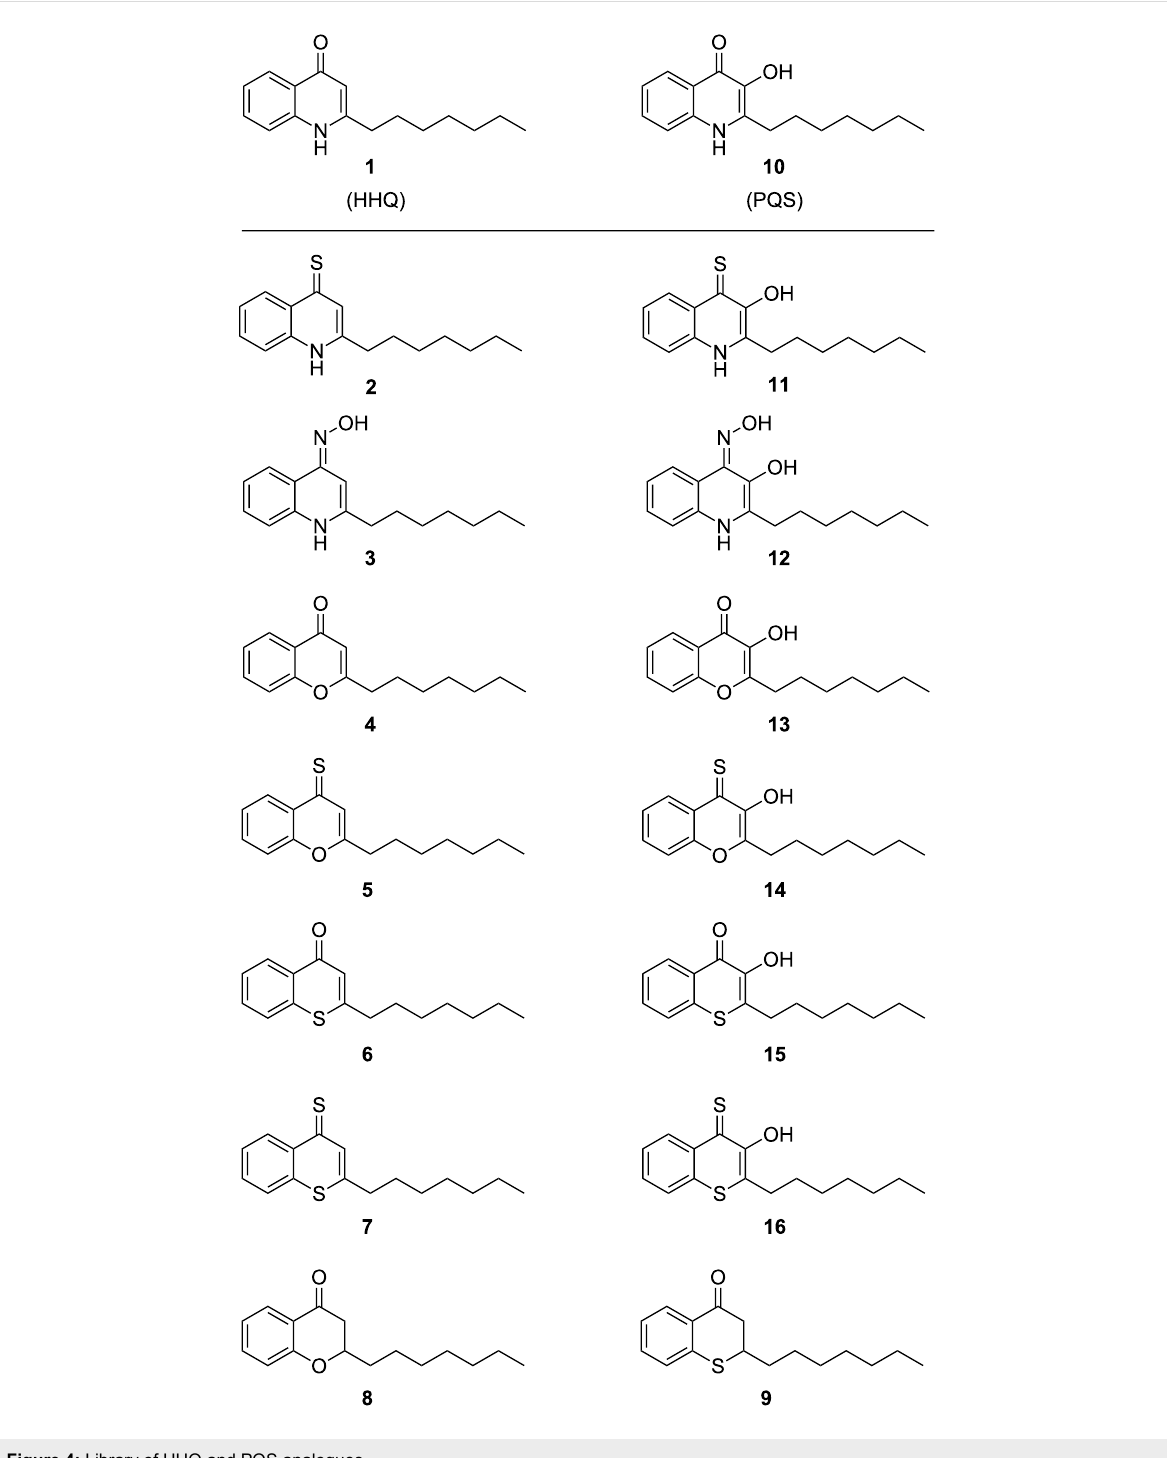
findings may guide the future development of covalent PqsD